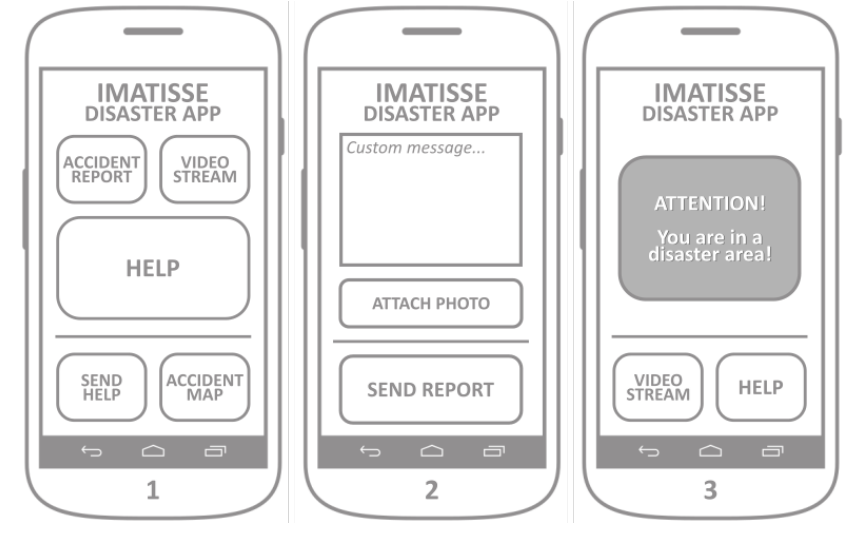
Figure 12. Crowdsensing application.